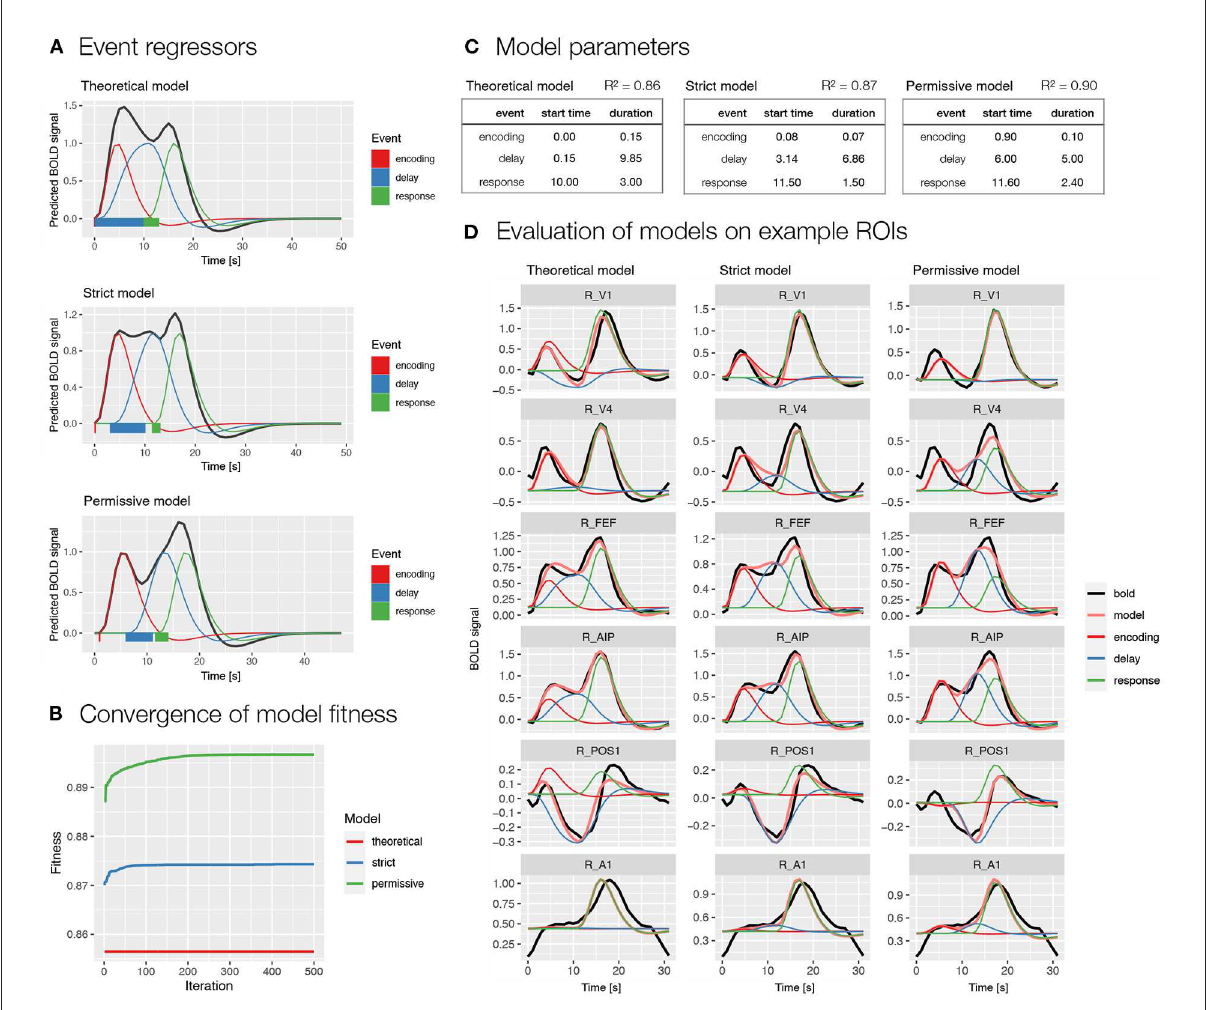
FIGURE4 Specification and performance of theoretical and automatically derived event models in the spatial working memory study. Here, we compare three models differentiating between encoding , delay and response events, a theoretically derived model based on the assumed timeline of events in the task and two automatically derived models based on the empirical BOLD signal using the autohrf function that differed in the predefined constraints, the permissive model was allowed larger deviations from the theoretical model than the strict model. The models were fit to the activity of a predefined selection of 80 ROIs in the frontoparietal network, in addition to visual and motor-related brain areas that were assumed to show responses to the task. (A) A visualization of task event predictors convolved with double-gamma HRF obtained using the plot_best_models , where the colored lines depict individual responses to specific events and the black line shows the summation of these responses in the BOLD signal. Rectangles at the bottom visualize the onset and duration for each of the events in the model. (B) The convergence of the model fitness in the automated parameter search based on the population of 100 and 500 iterations. The plot was obtained using the plot_fitness . (C) Theoretical and data-driven onset and duration of task events in the models. The R 2 shows the mean fitness of the models across the selected 80 ROIs. (D) The evaluation of the models on six example ROIs (i.e., R_V1, right primary visual cortex; R_V4, right fourth visual area; R_FEF, right frontal eye fields; R_AIP, right anterior intraparietal area; R_POS1, right parieto-occipital sulcus area 1; R_A1, right primary auditory cortex; Glasser et al., 2016) with different types of BOLD response during a spatial working memory task. The plots were prepared using the plot_model , where the black line shows the average BOLD response, the pink line the modeled BOLD response and the thin colored lines depict individual responses to specific